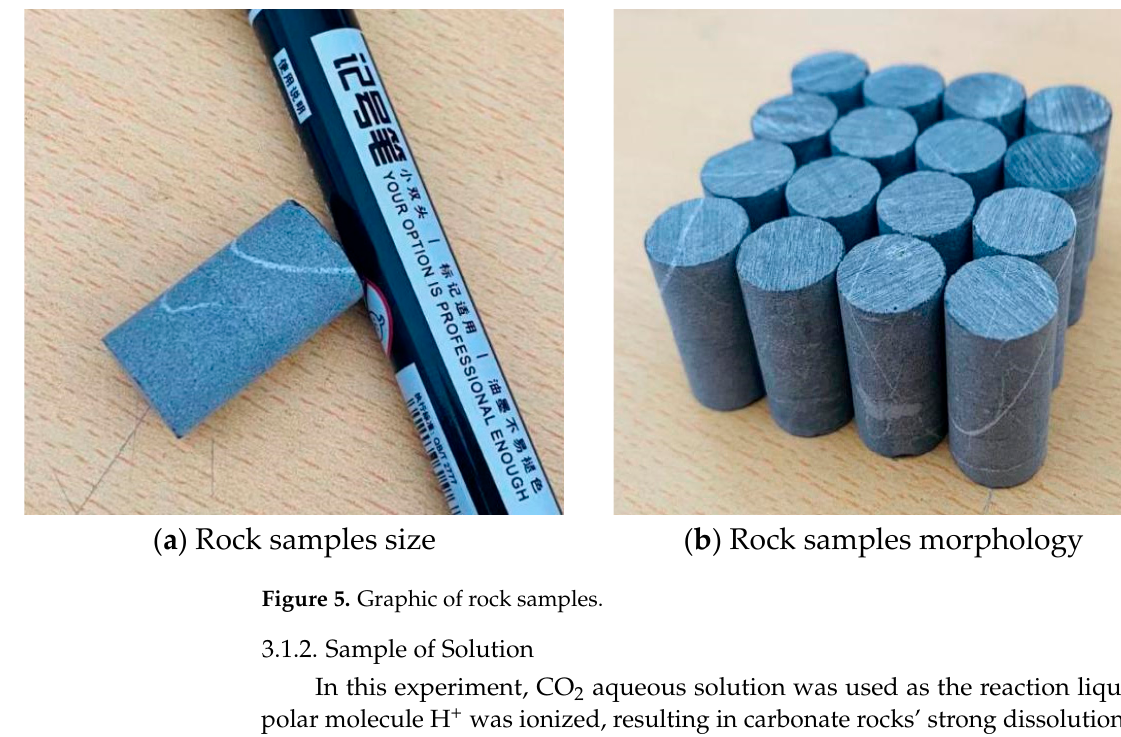
Figure 5. Graphic of rock samples.